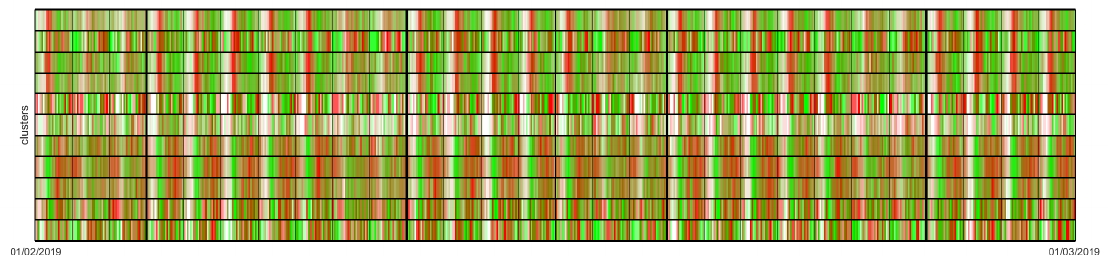
Figure 5. Colour map for 11